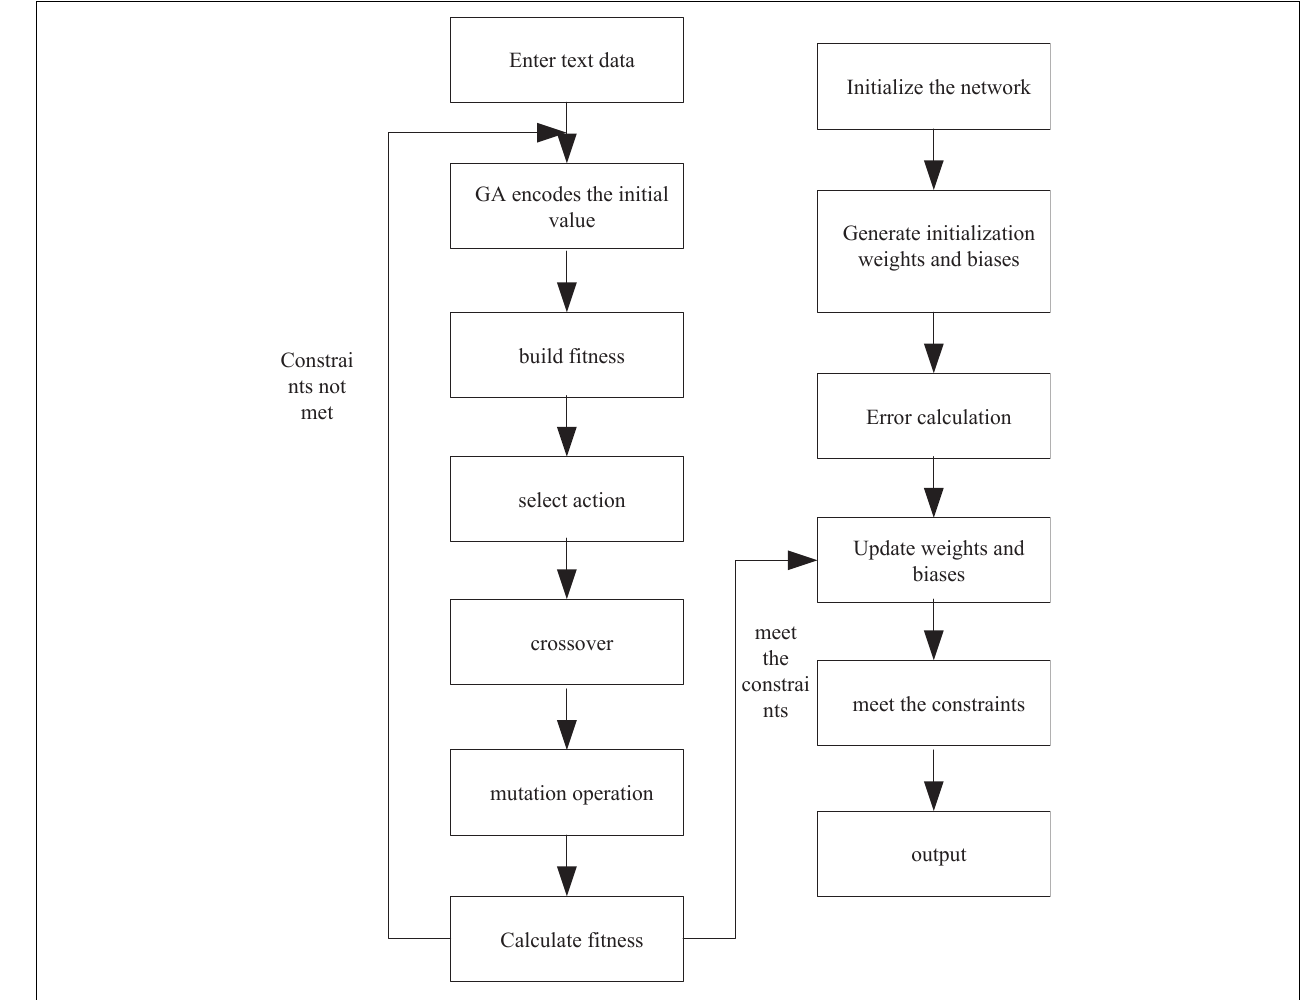
FIGURE 2 | Flow chart of the genetic algorithm optimized convolutional neural network (GA-CNN) model.